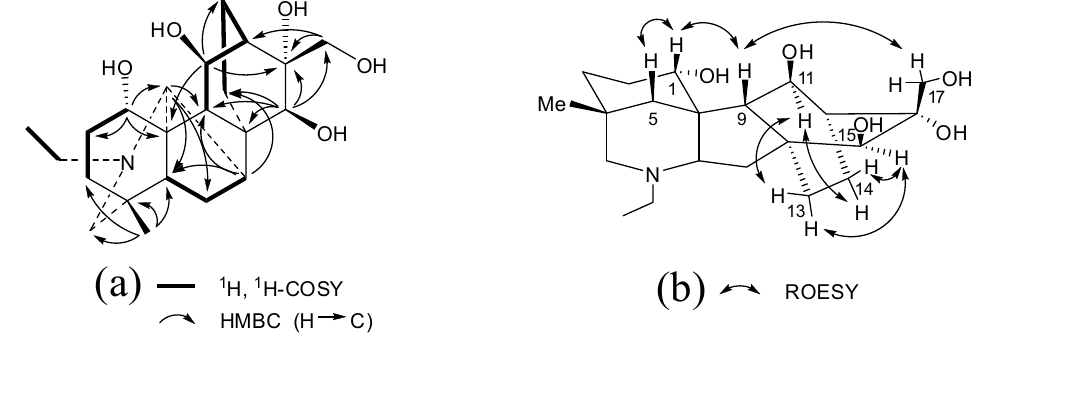
OD, δ in ppm, J in Hz). 3